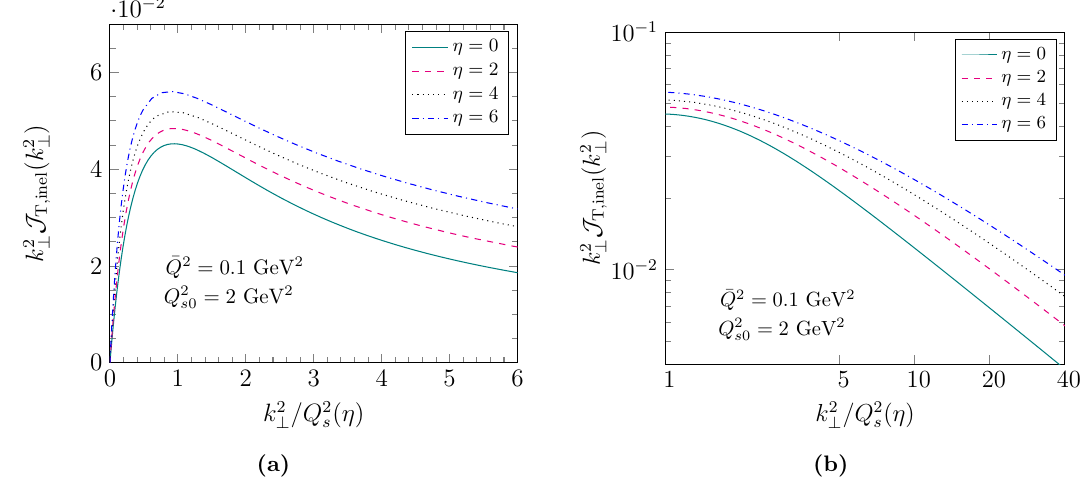
Figure 6. Approximate geometric scaling behaviour of the transverse inelastic cross section mul- tiplied by k 2 at (a) low and intermediate transverse momenta and (b) high transverse momenta. ⊥ With increasing η the high- k ⊥ tail becomes slightly